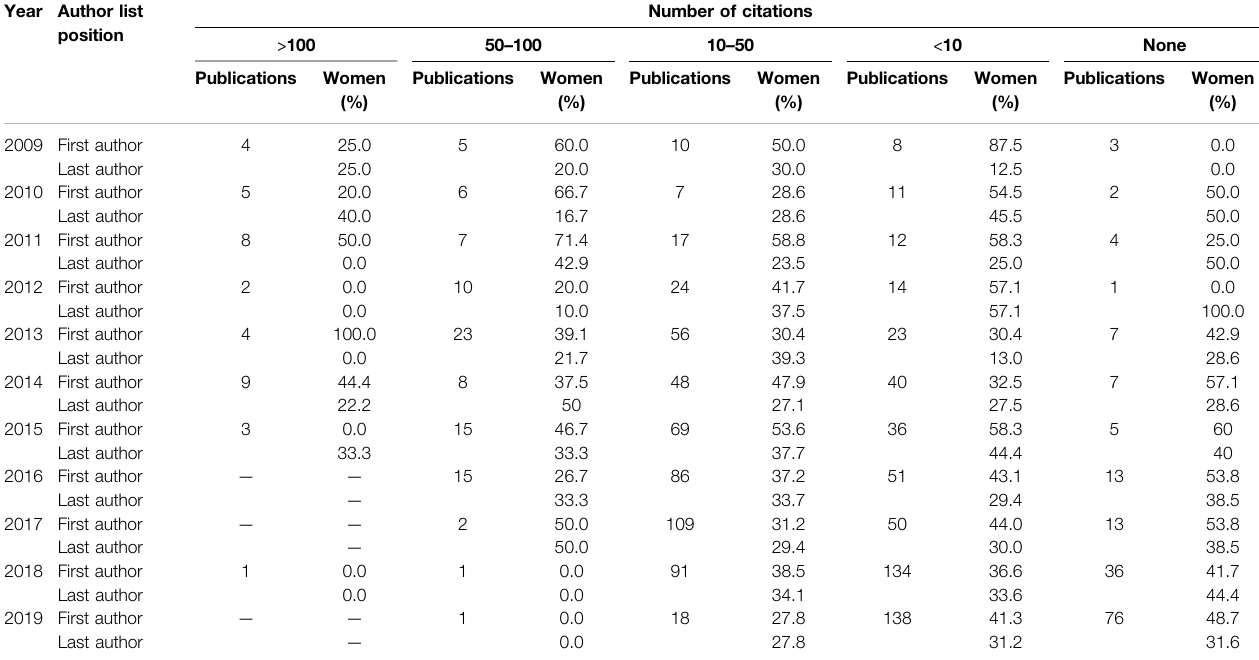
TABLE 2 | Correlation between female authors and the number of publication citations (data refer to papers published in 2009 –